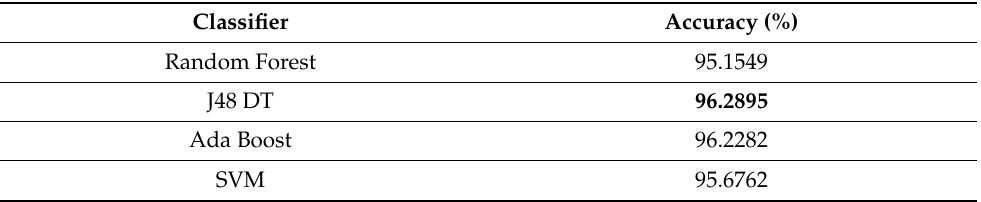
Table 8. Comparative results for the